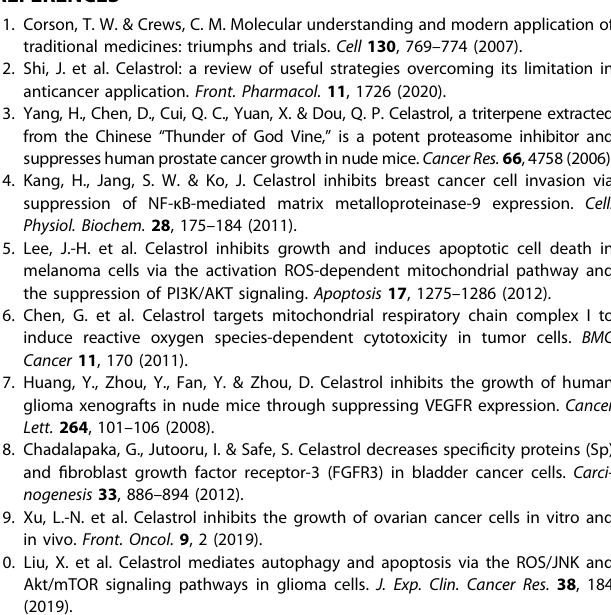
Supplementary Table 2 and survival curve. For chronic toxicity test, mice were randomized into three groups. Each group of mice were intraperitoneally injected with vehicle, 2 mg/kg Celastrol or 2 mg/kg 19-048 5 days per week for 2 weeks (totally ten times). Blood samples were collected using EDTA tubes for the routine blood test on day 6 or day 12